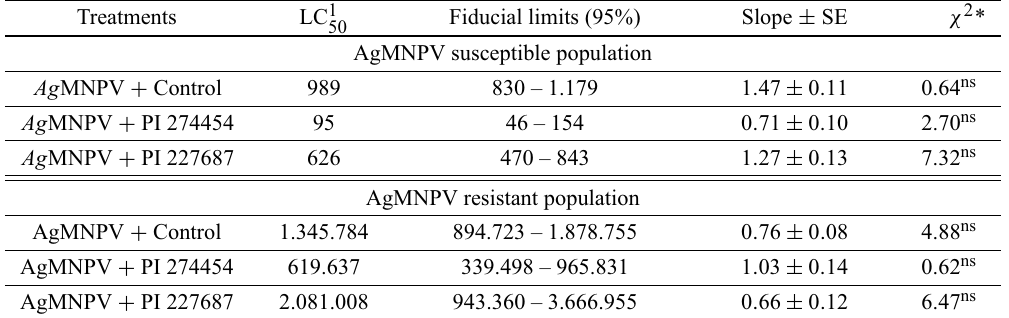
1 Median lethal concentrations (LC 50 s) expressed in units of polyhedral occlusion bodies/ml of diet in bioassay. * χ 2 significant at P < 0 . 05.